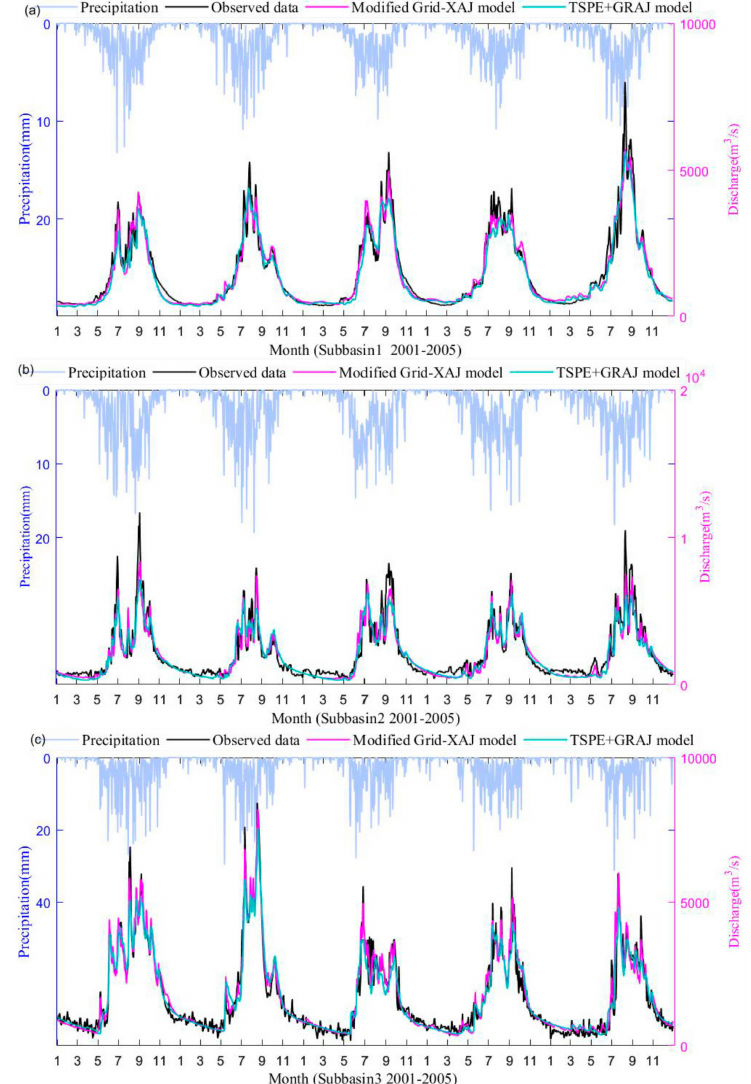
Figure 4. Time series of observed and estimated daily streamflow hydrographs from the modified GRAJ model and the TSPE+GRAJ model in the calibration period; ( a ) Sub-basin 1; ( b ) Sub-basin 2; ( c ) Sub-basin